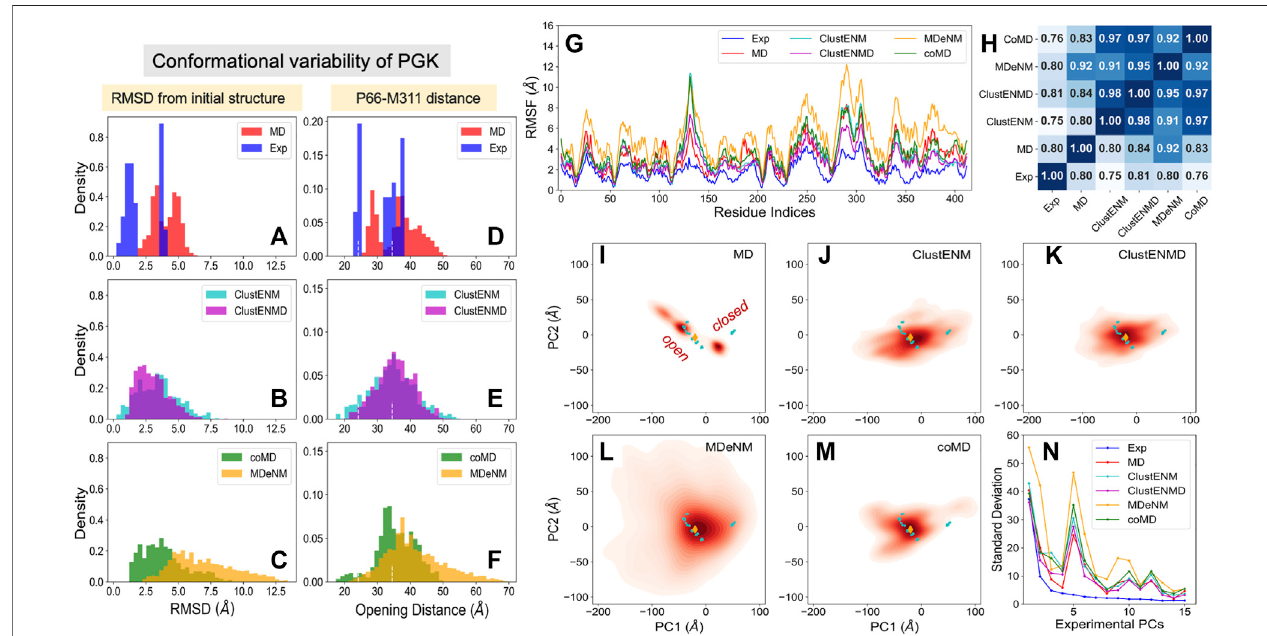
FIGURE 6 | Comparison of computational and experimental ensembles of PGK. The panels are in the same format as Figure 2 (A – C ) RMSDs with respect to the starting open structure (PDB id: 2xe7). (D – F) Distances between the α -carbons of P66 and M311 that monitors the opening-closing motion of PGK. Dashed lines indicate the distances of the initial open, and a catalytically fully closed crystal structure (PDB id: 2wzb). (G) RMSFs for each ensemble , (H) Pearson correlation coef fi cients between all pairs of RMSF pro fi les. (I – M) Population distributions of ensembles of conformers generated by simulations, projected onto the subspace spanned by e PC1 and e PC2, shown for (I) MD simulations, (J) ClustENM, (K) ClustENMD, (L) MDeNM, and (M) coMD. (N ) Standard deviations of the conformers projected along the experimental